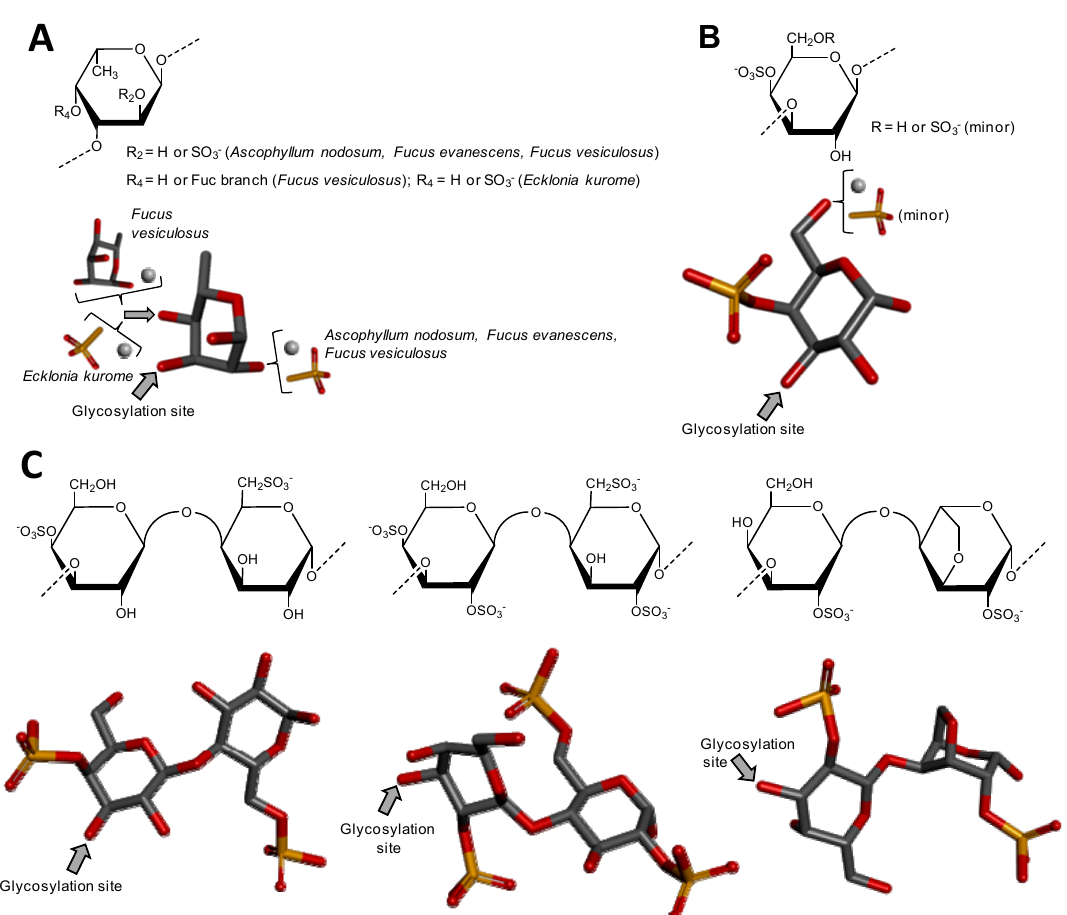
Figure 4. Haworth projections and stick model representations of the major components in sulfated fucans and sulfated galactans from seaweeds. ( A ) The sulfated fucans from the well-known brown alga species Ascophyllum nodosum , Fucus evanescens , Fucus vesiculosus and Ecklonia kurome are mostly composed of α (1 → 3)-linked α - L -Fucose (Fuc) units highly substituted by sulfation at C2 and C4 positions [55,62]. Branches of Fuc units can also occur at the C4 position through α -linkages [55,63]. ( B ) The sulfated galactan from green algae are dominantly composed of α (1 → 3)-linked galactose (Gal) units sulfated at position C4 [51]. ( C ) The sulfated galactans from red algae are mostly composed of regular disaccharide units alternating 3-linked β -Gal and 4-linked α -Gal residues as illustrated with the different types of carrageenans with different substitutions of sulfation and occurrence of the 3,6-anhydro-galactose units such as μ (mu) left structure, λ (lambda) middle structure and θ (theta) right structure [64]. The colors of the atoms used in the representations are grey for carbon, blue for nitrogen, red for oxygen and yellow for sulfur. The hydrogen atoms were omitted on the structures for visual simplification but are represented in light grey discs as possible substituents. The arrows labeled as “Glycosylation site” indicate the position of the glycosidic bond. Structures were created using ChemDraw Ultra 8.0 for Haworth projections and submitted to MM2 force-field. Then, Discovery Studio Visualizer v.4.5 software (BIOVIA, Dassault Systèmes) was used for 3D representations after energy minimization. The monosaccharides are displayed in their commonest chair configurations: 1 C 4 for Fuc and 4 C 1 for Gal.